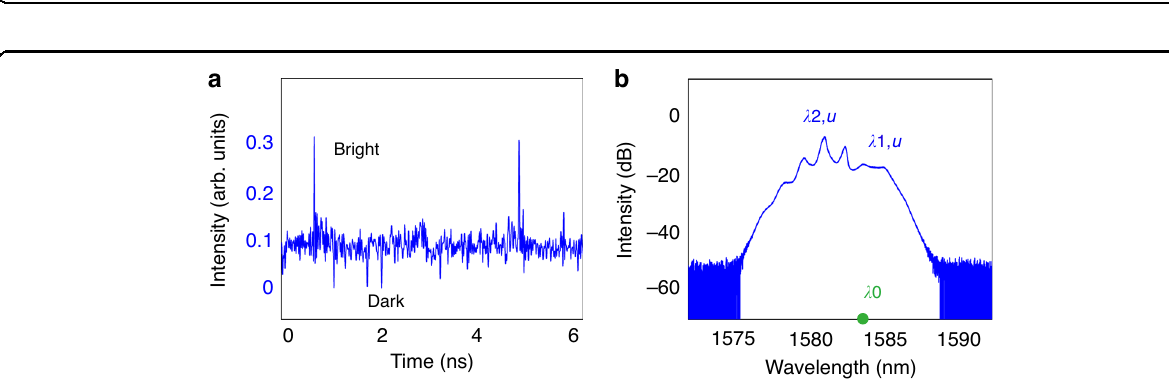
Fig. 2 Simultaneous formation of orthogonally polarized DSs and BSs. a Polarization-resolved laser emissions. Blue solid line and red solid line: laser emission along two polarization axes. b The corresponding optical spectra of ( a ). c Schematic illustration on the soliton wavelengths. λ 0 : the position of ZGVD point, λ 1, u : central wavelength of the BSs, λ 2, u : central wavelength of dispersive waves, λ 1, v : central wavelength of the